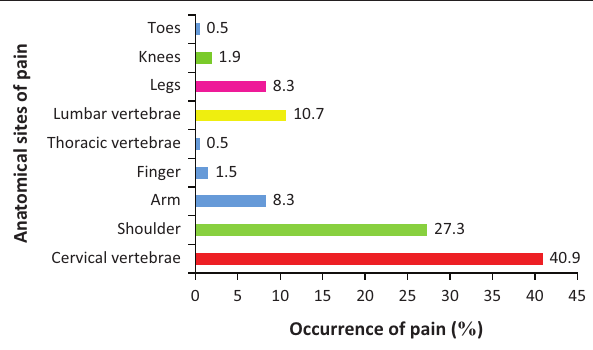
FIGURE 2: Graphic display of the anatomical sites most vulnerable to cranial loading–induced musculoskeletal